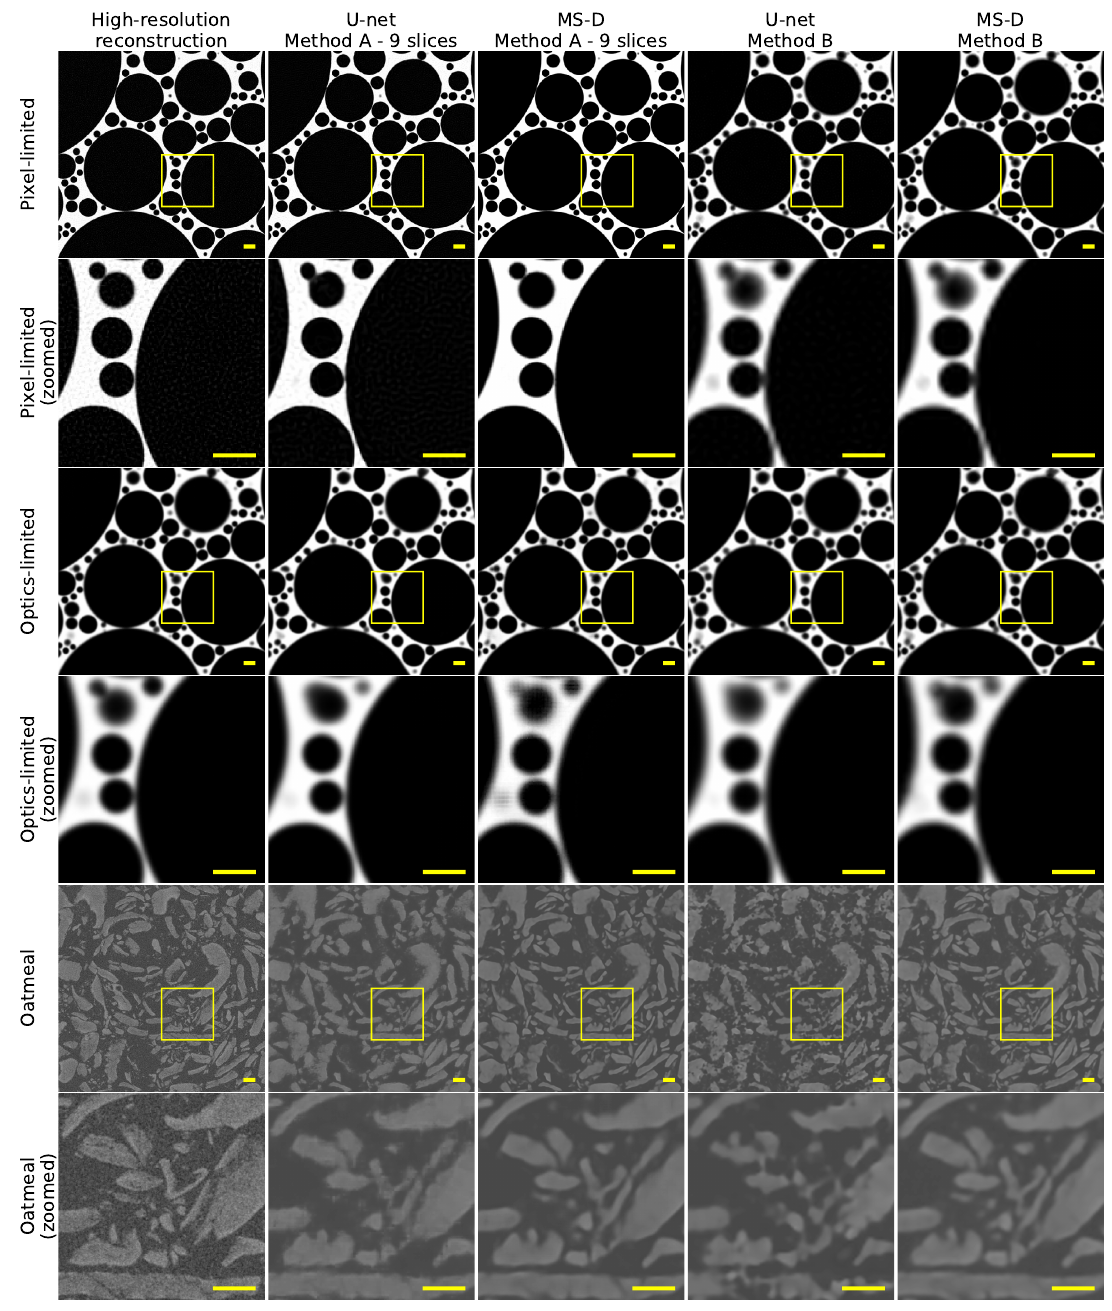
Figure 10. Comparison of U-net and MS-D on the central slice of the upper region of interest. The high-resolution slice (left-most column) is the result of reconstruction (Equation (12)). The four columns on the right are computed from a low-resolution reconstruction using a U-net or MS-D network. The first and third row display the results on simulated data, and the fifth row displays the results on experimentally acquired oatmeal data. Magnifications of the central yellow square are displayed in the even rows. The output of method B is cubically up-sampled by a factor of 4 to be the same size as the other